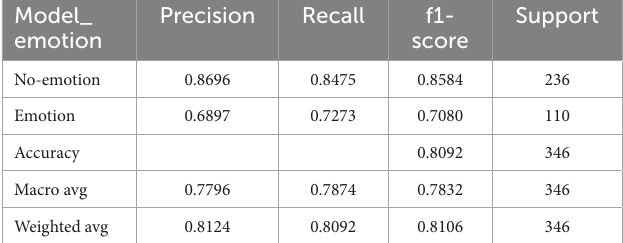
TABLE 2 Evaluation of model for emotional and nonemotional